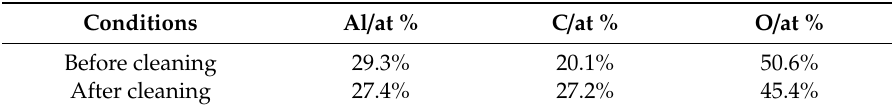
Table 2. Quantification of the concentrations of the laser processed aluminum alloy sample #1 before and after ultrasonic cleaning by XPS analysis (at